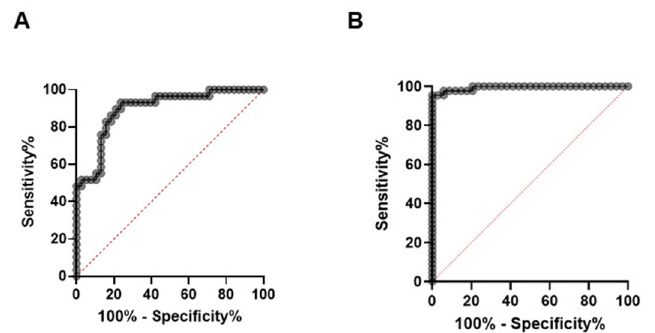
Figure 5. ROC (receiver operating characteristic) curve of the HBV RPA-LFA test. ( A ): 89 HBV- positive plasma samples alongside 19 HBV-negative plasma samples extracted with 50 µ L 5% Chelex 100 solution, ( B ): 89 HBV-positive plasma samples alongside 19 HBV-negative plasma samples extracted with 500 µ L 5% Chelex 100 solution.